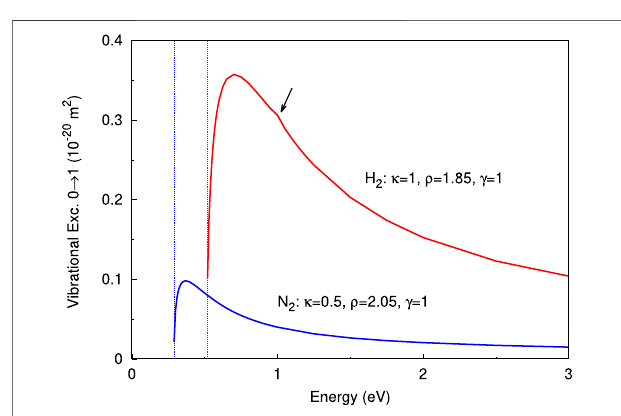
FIGURE 7 | (Color online) 0 → 1 vibrational excitation cross sections for H 2 and N 2 , obtained with model potentials calibrated to the values of the free parameters. The vertical lines indicate the threshold energies for the 0 → 1 vibrationalmodeandthearrowdrawsattentiontothesmallpeakcaused by the opening of the 0 → 2 vibrational channel.